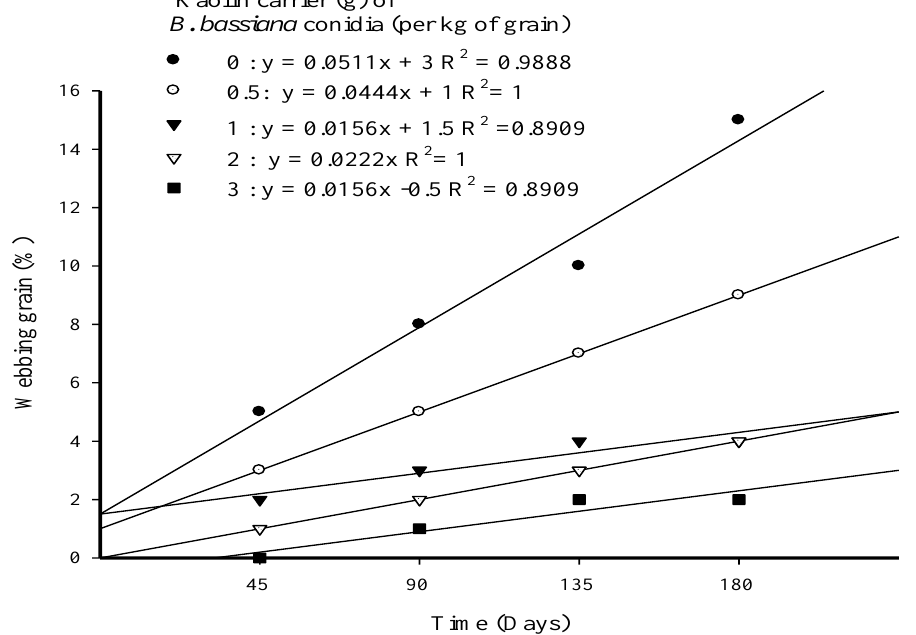
Figure 3. Webbed grains over 180 days of Ephestia cautella larvae infestation of rice following treatments with Beauveria bassiana Strain MS-8 at 0.03 g conidia kg −1 formulated in various doses of kaolin.